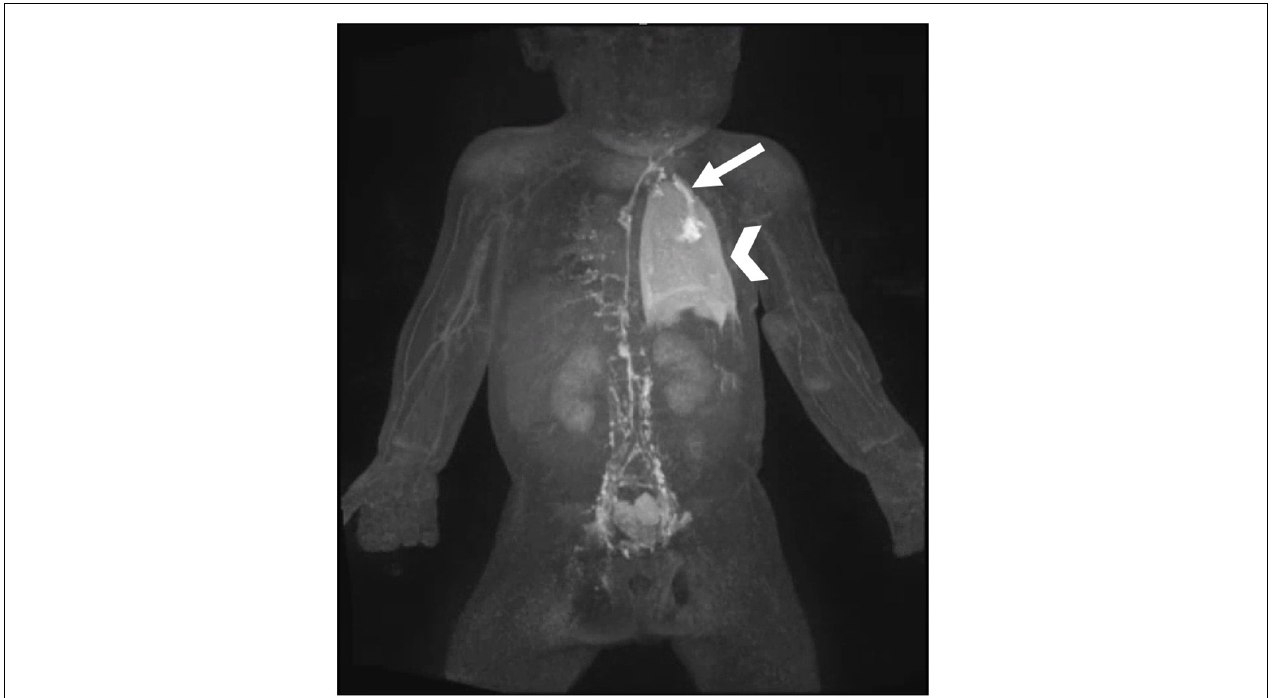
FIGURE 3 | MIP coronal projection of IN-DCMRL demonstrating leak of contrast into the left pleural space (arrowhead) from dilated channel connected to the pericardium and originating from the distal TD (arrow).